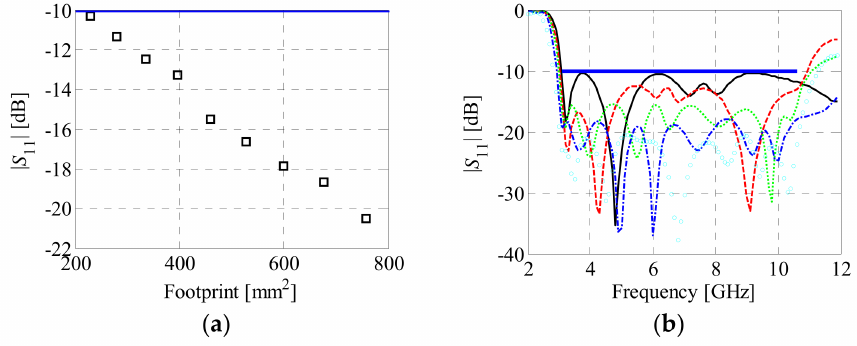
Figure 8. Spline-parameterized antenna’s ( a ) Pareto set and ( b ) reflection responses obtained for the designs x 1.20* (—), x 3.20 * (- -), x 5.20 * ( ··· ), x 7.20 * ( · - · ), and x 9.12 * ( ◦◦◦ ).